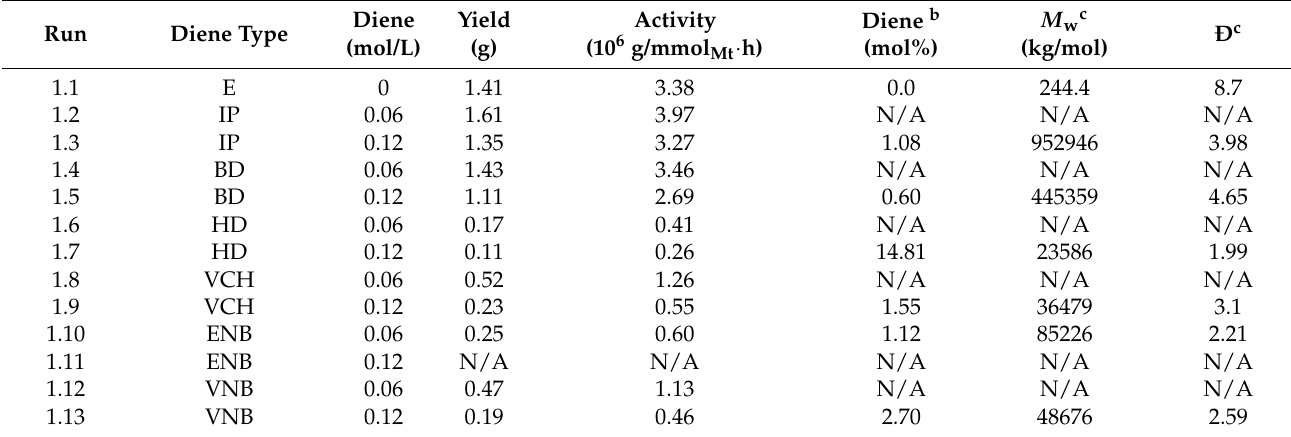
Table 1. Ethylene-diene copolymerizations catalyzed with rac -Me 2 Si(2-Me-4-Ph-Ind) 2 ZrCl 2 (complex A)/Ph 3 C][B(C 6 F 5 ) 4 / TIBA a ).